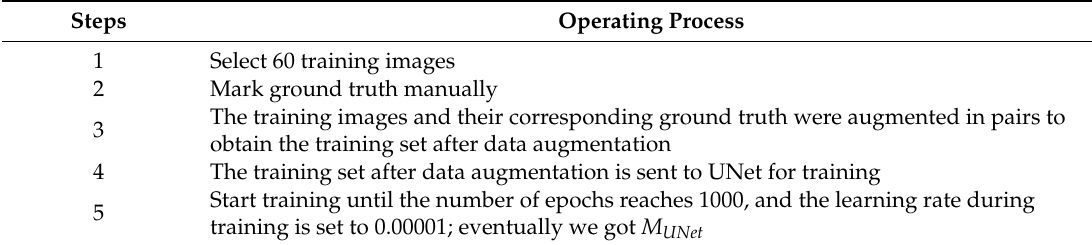
Table 1. Training process of UNet branch.